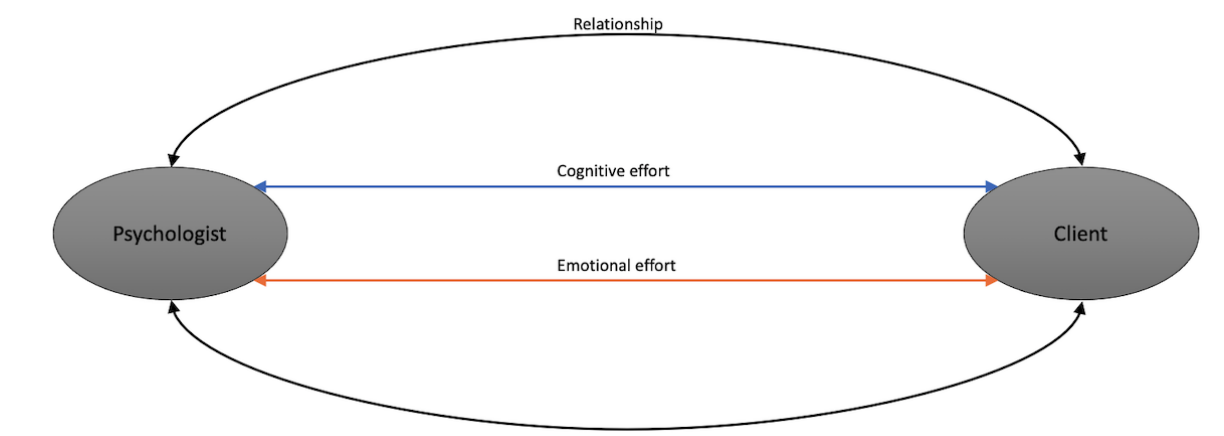
Figure 1. Face-to-face psychotherapy